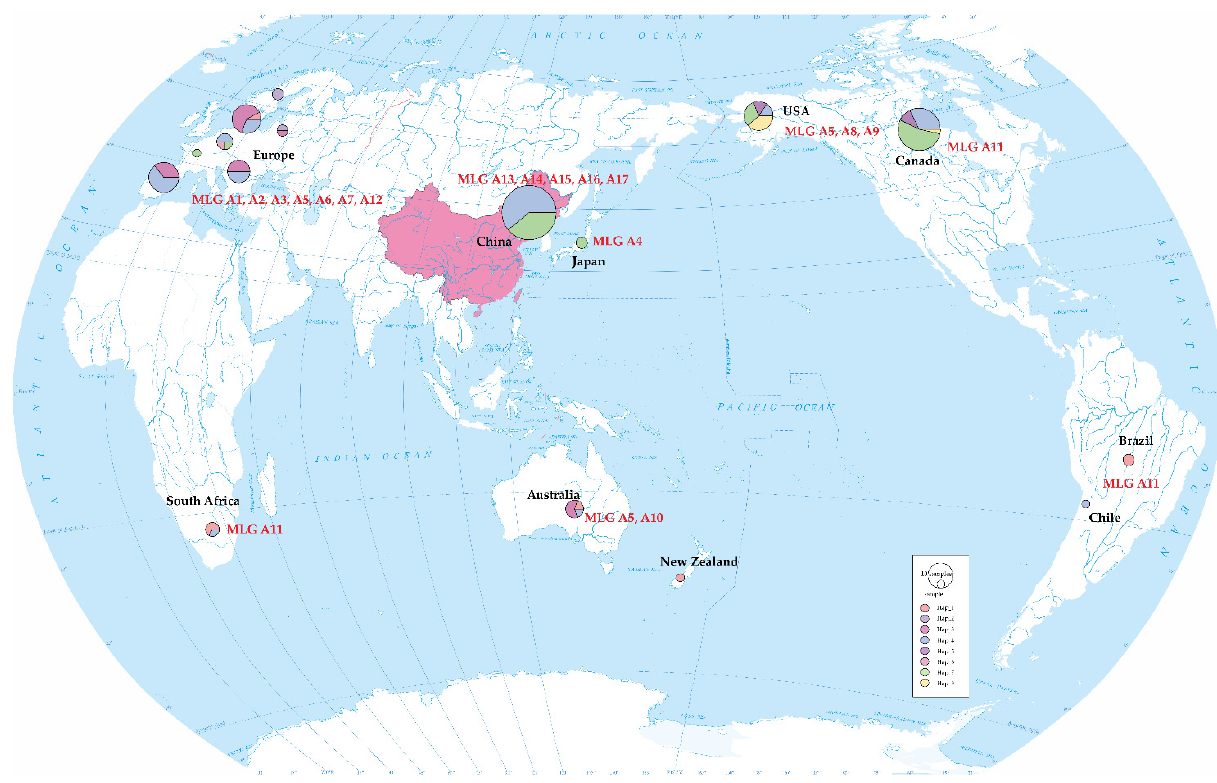
Figure 6. Global A. areolatum associated with woodwasp population haplotype distribution, based on the IGS region and MLGs.